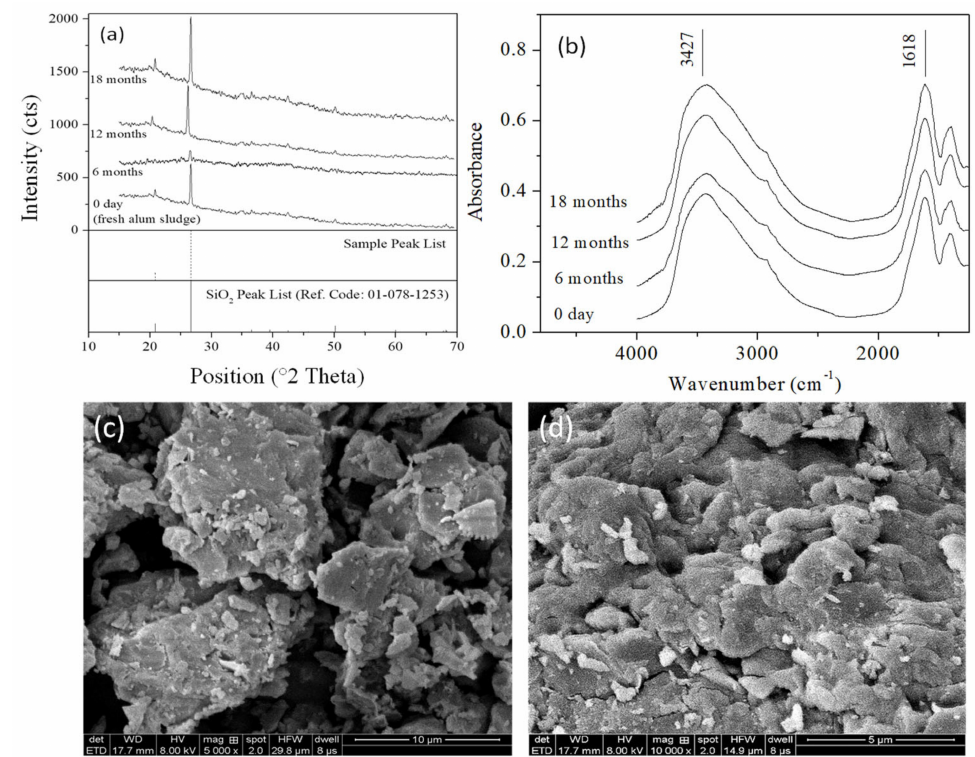
Figure 3. XRD ( a ) and attenuated total reflection–Fourier transform infrared ( b ) spectra of Alum sludge (AlS) samples with ageing times and scanning electron microscope images of AlS with magnitude of 5000 ( c ) and 10,000 ( d